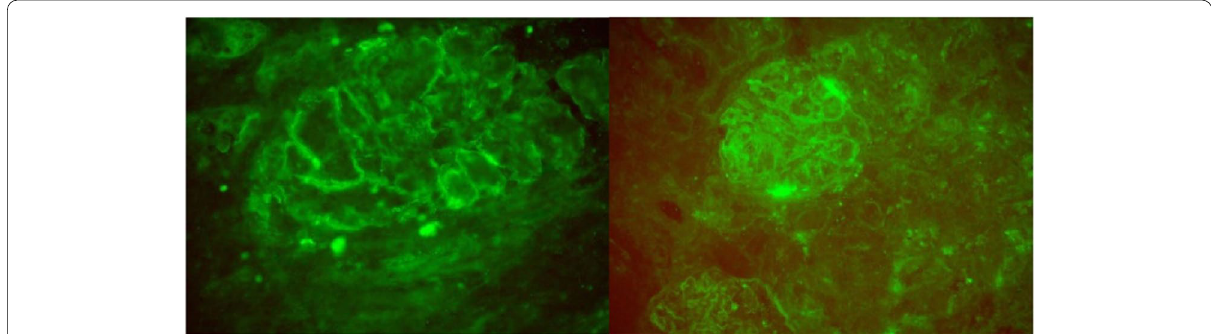
Fig. 4 Peripheral membrane deposit of IgA and